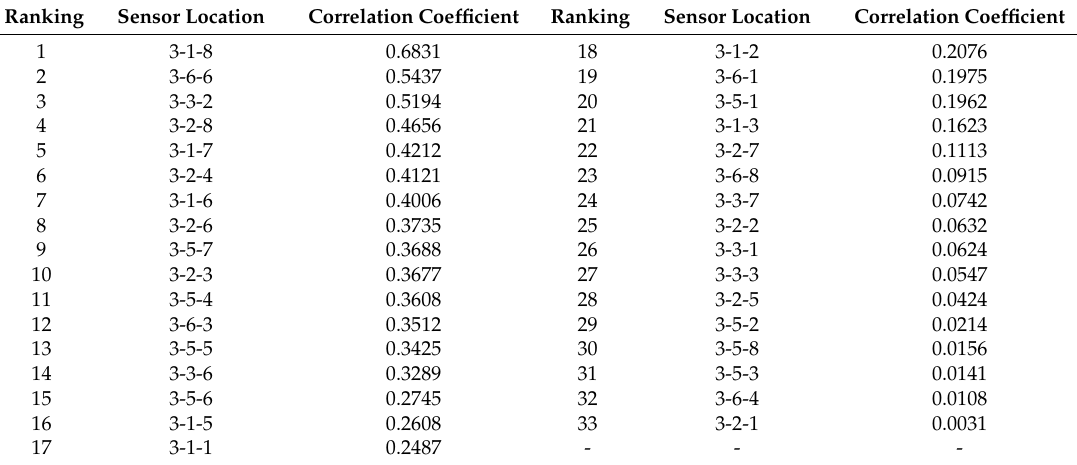
Table 1. The correlation degree of stress monitoring data between stress sensor 3-1-4 and other stress sensors.